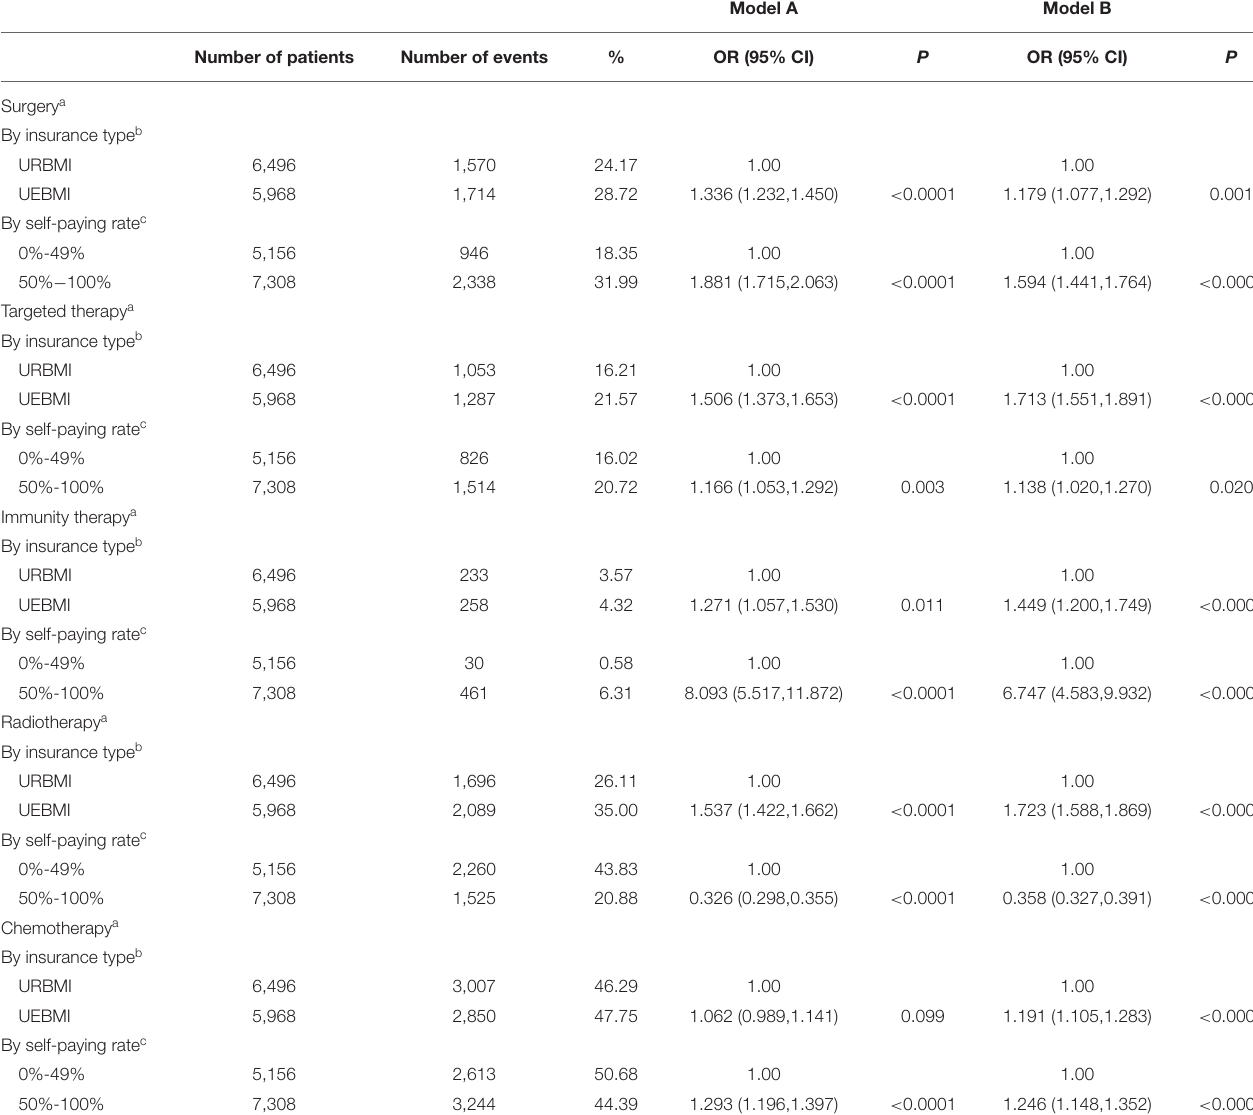
Model A Model B